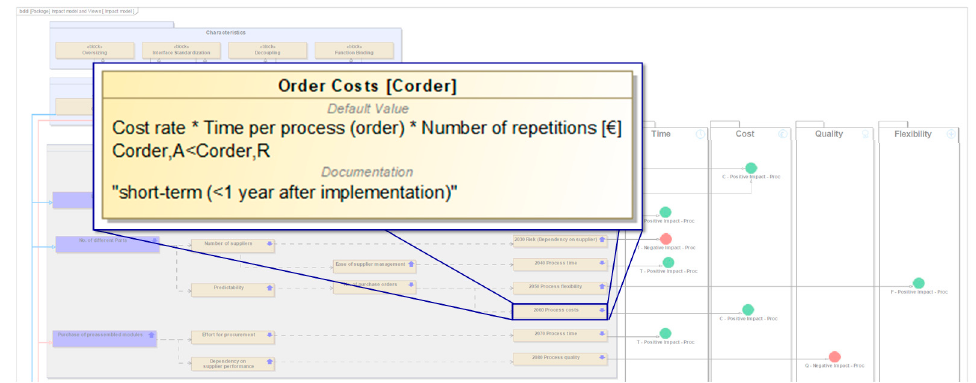
Figure 7. Implementation of the new KPIs and the information about the temporal occurrence of effects in the Sys-IMF using the example of order costs (ID 2060).